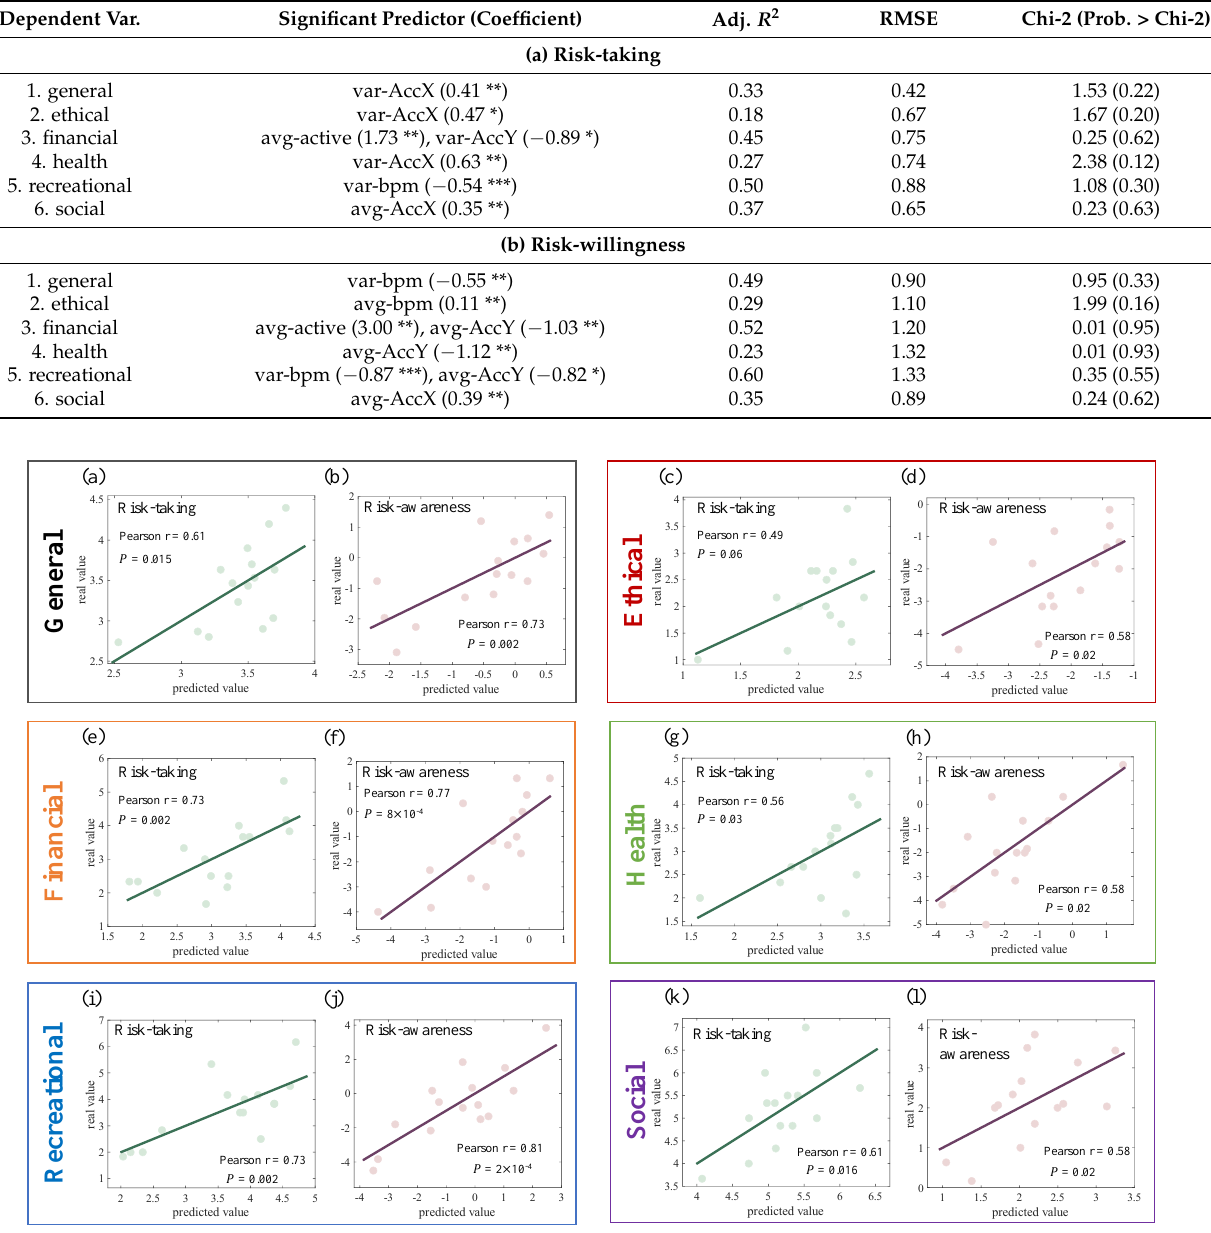
Figure 3. Comparison between the predicted risk-preference score and the realistic self-reported value ( N = 15) over six domains of Study B ( a , b for general, c , d for ethical, e , f for financial, g , h for health, i , j for recreational, k , l for social). The predicted value is calculated using significant predictors and the corresponding coefficients reported in Table